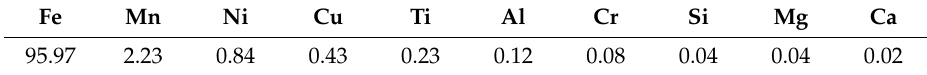
Table 2. Elemental composition of the flakes collected from the operating SG using ICP-AES (wt.%). Fe Mn Ni Cu Ti